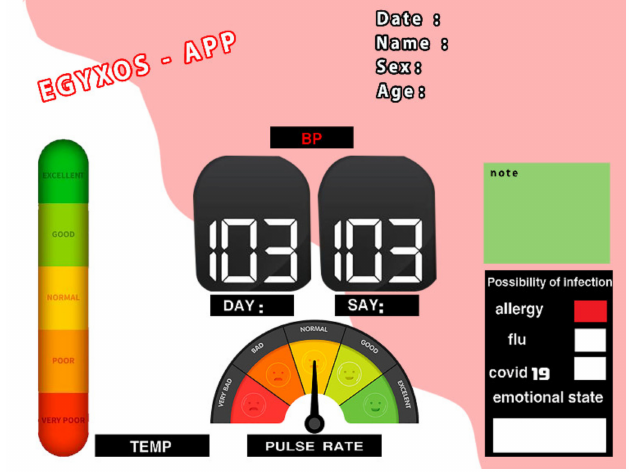
Figure 7. Mobile application for EGYXOS based on sensor